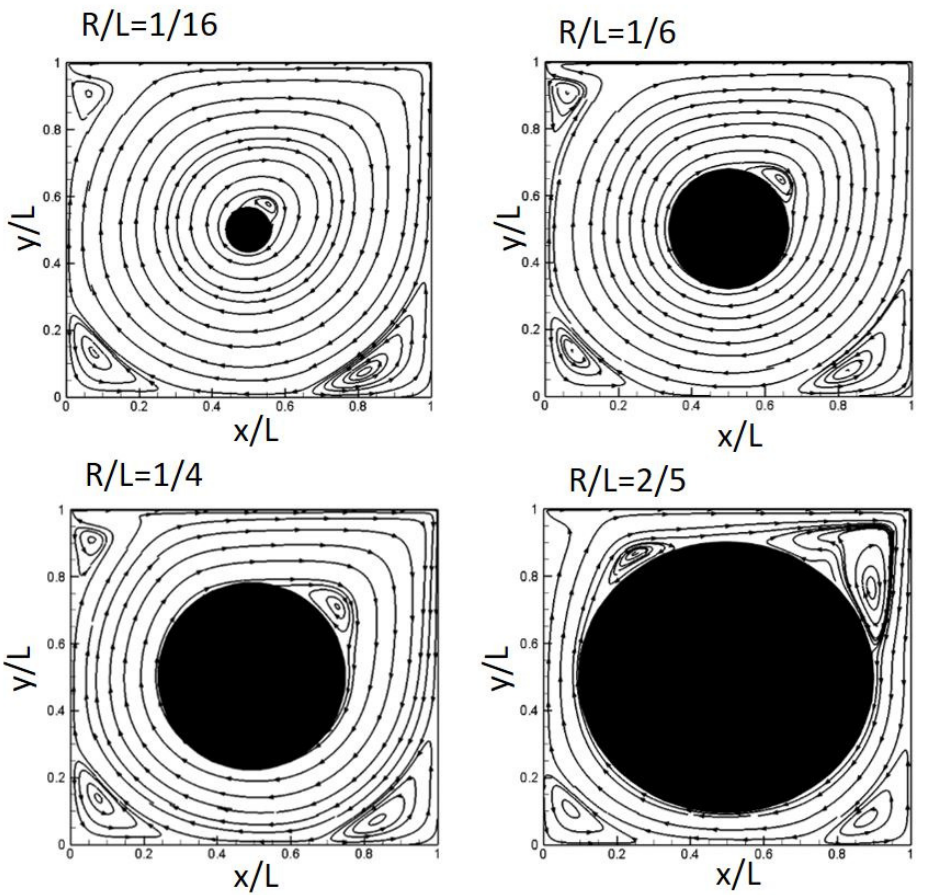
Figure 15. Streamline distributions for an obstacle of various